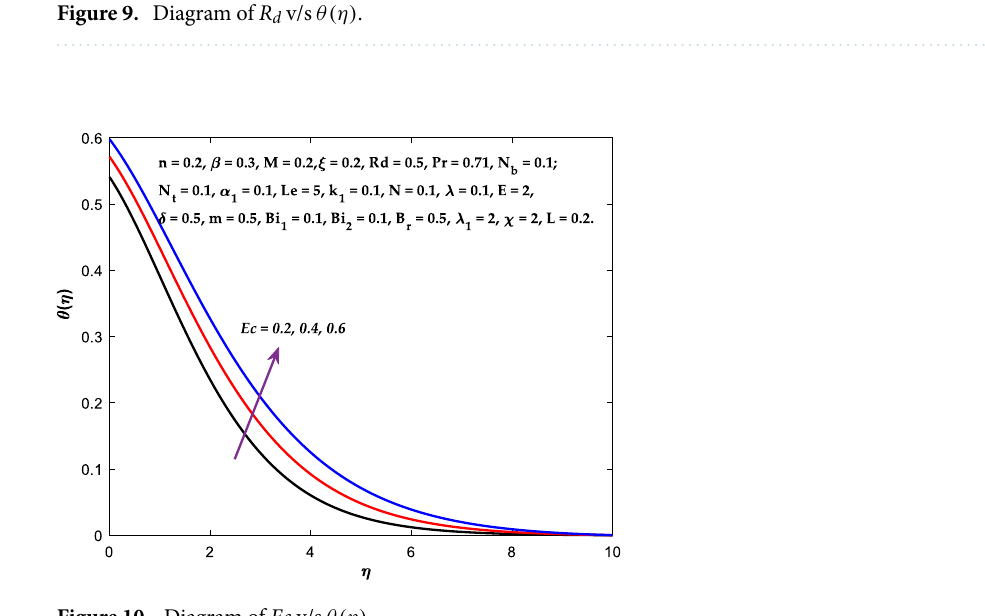
Figure 10. Diagram of Ec v/s θ(η)